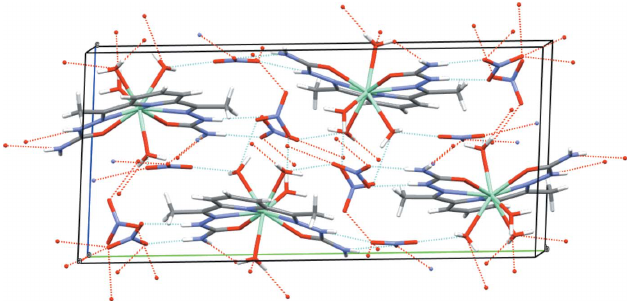
Figure 2 Packing (Mercury; Macrae et al. , 2008) as viewed along the (100) direction showing the counter-anions as well as hydrogen-bonding interactions (dashed lines). The minor component of the disordered nitrate group was omitted for